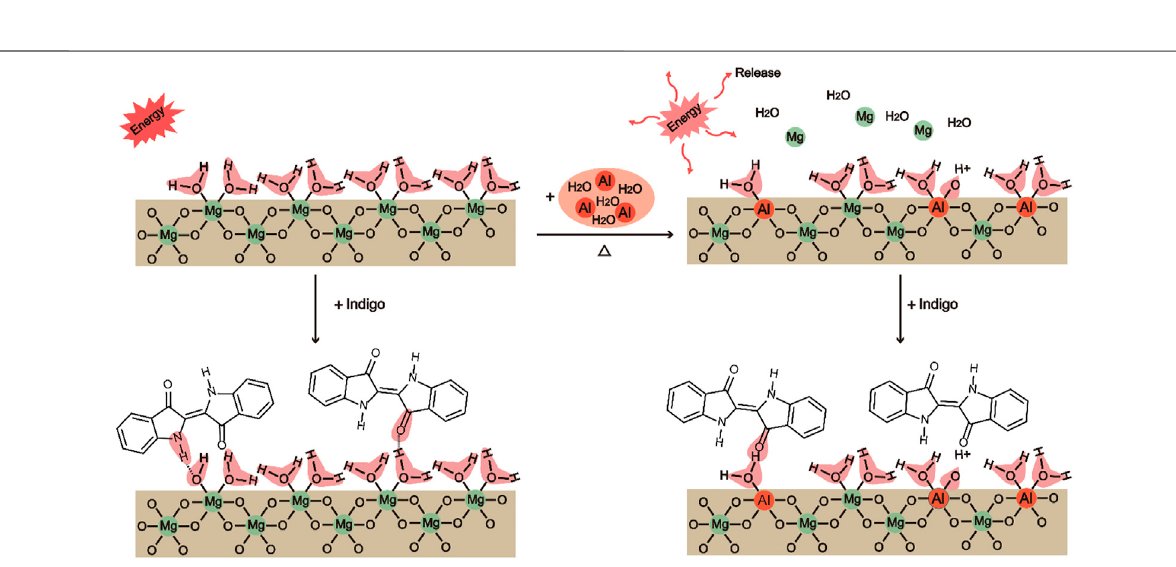
Frontiers in Chemistry |